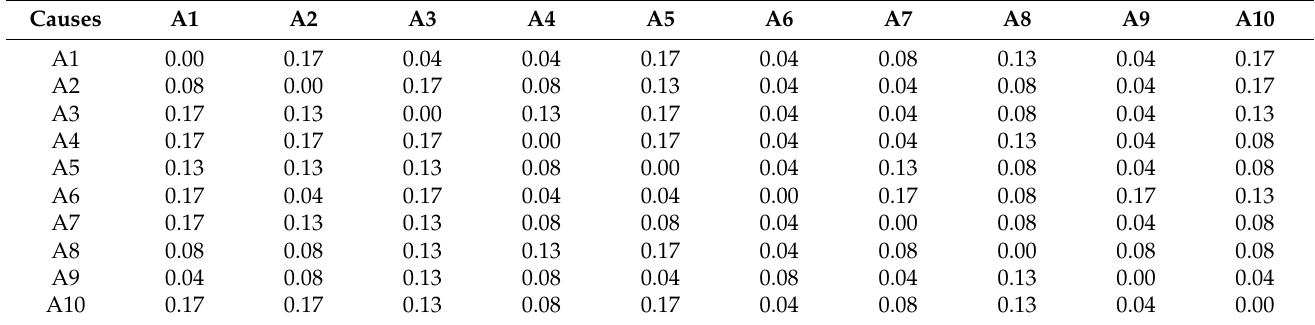
Table 3. Normalized matrix of direct impact for porosity cluster on the mechanical seal.